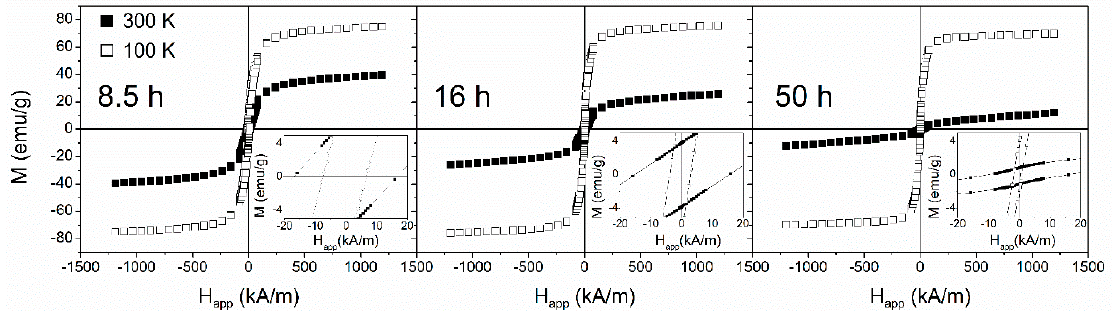
Figure 5. Magnetic hysteresis loops, taken at 100 (open symbols) and 300 K (solid symbols), of the mechanically alloyed Fe 70 Zr 30 powders for the selected milling times. The inset shows the low field region of the hysteresis loops.